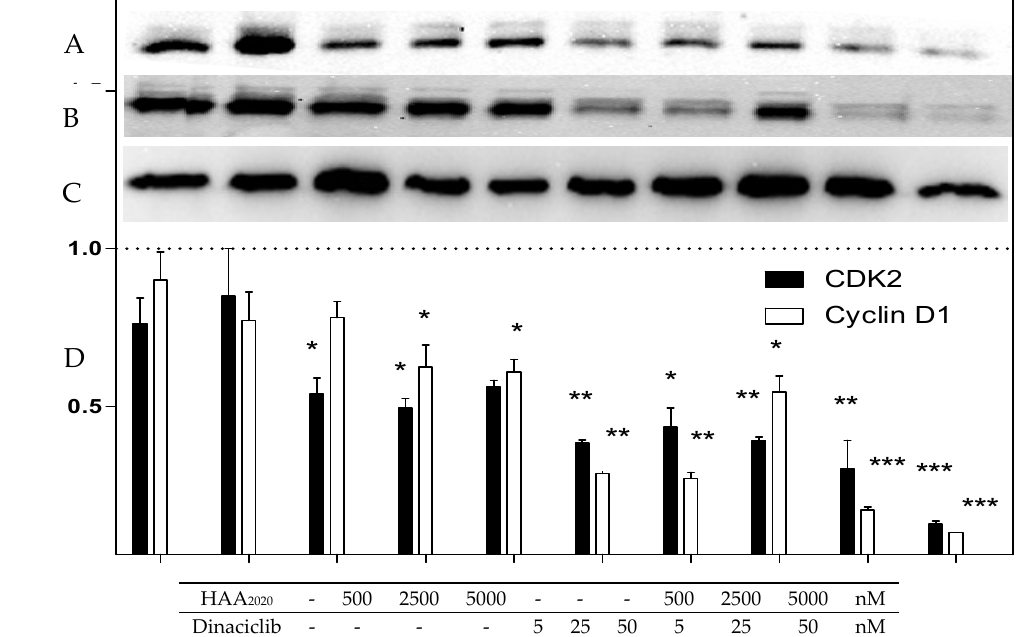
Figure 7. Level amount of CDK2 and Cyclin D1 in MCF7 cells treated with either HAA 2020 (500, 2500, 5000 nM), dinaciclib (5, 25, 50 nM), or their combinations for 24 h. ( A – C ): immunoblots of CDK2, cyclin D1, and GAPDH, respectively. ( D ): Data is represented as mean ± SD ( n = 2, two independent experiments). Statistical di ff erences of the relative protein levels normalized to GAPDH were assessed by one-way Anova with the Tukey’s post-hoc multiple comparison test. p < 0.05 (*), p < 0.01 (**), and p < 0.001 (***) were taken as significant. Image J software was used for